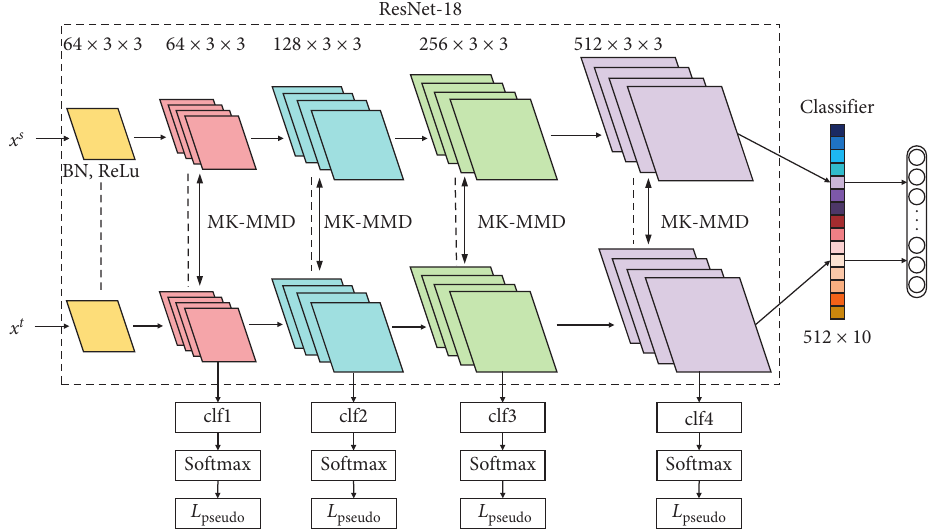
Figure 3: Architecture of the proposed MLDA